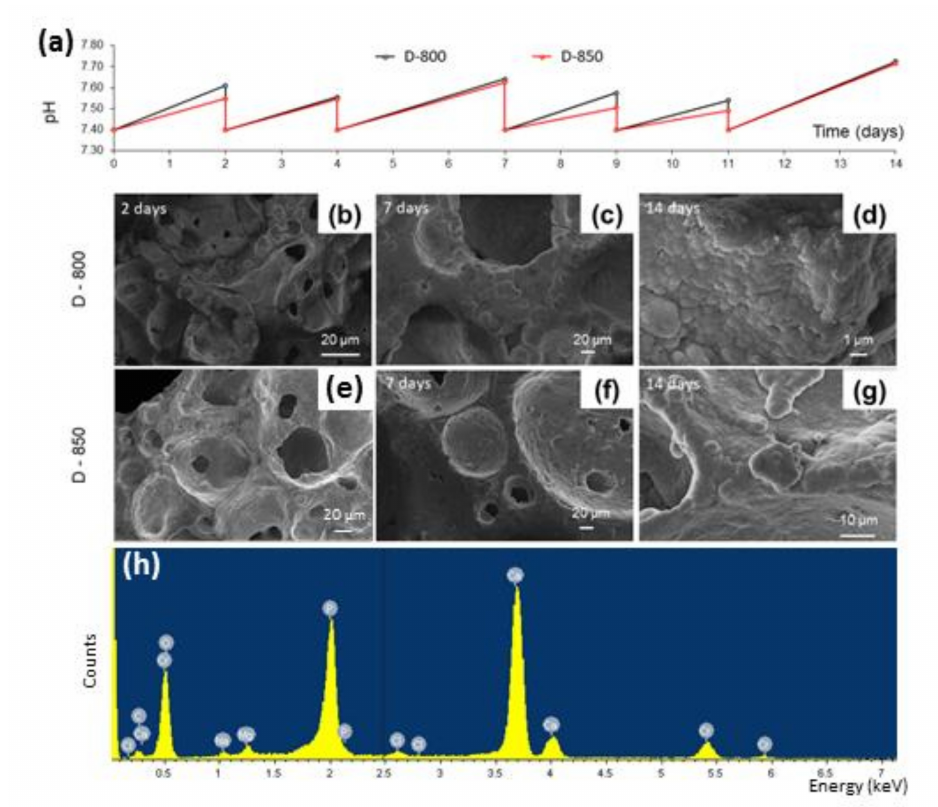
Figure 5. Bioactivity tests in simulated body fluid (SBF): pH variation as a function of the immersion time ( a ); FE-SEM micrographs of the surface of D-800 ( b – d ) and D-850 ( e – g ) sca ff olds after immersion in SBF for 2, 7, and 14 days; example of EDS spectrum of the newly formed surface layer on D-850 sample after seven days in SBF ( h